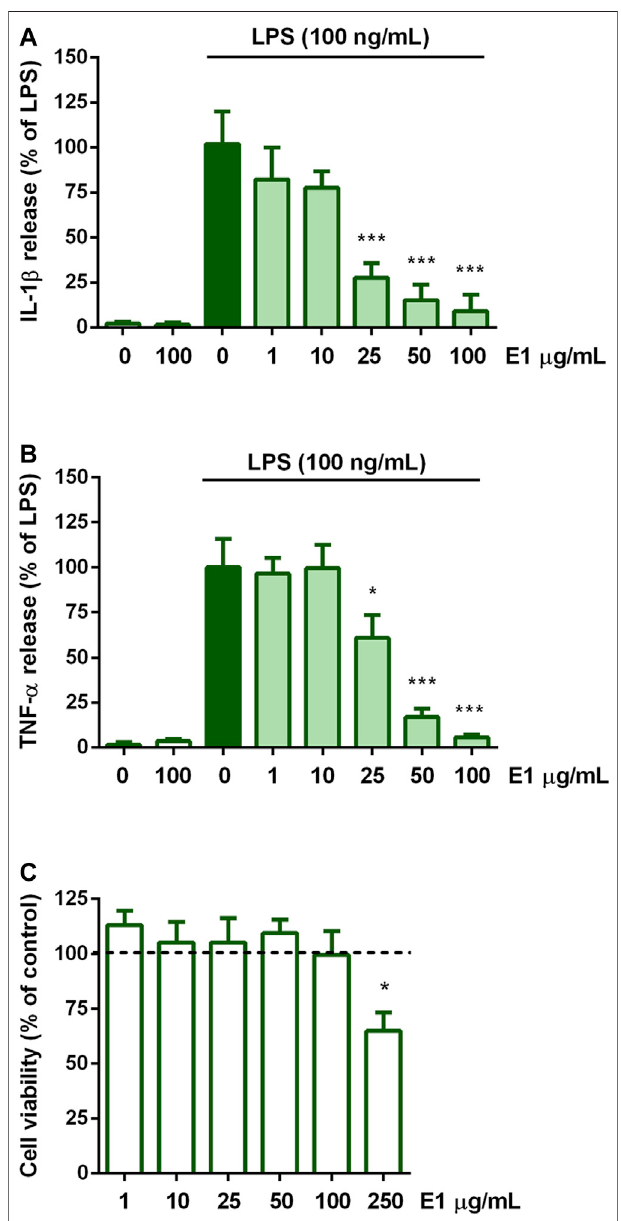
FIGURE 2 | Effect of pre-treatment with Spirulina extract on cytokine release from LPS-stimulated cortical microglia and cell viability analysis. Microgliawereculturedfor24 hin10%serum-containingmedium,whichwas replaced with serum-free medium before pre-treatment with E1 (1 – 100 μ g/ml) for 1 h and further stimulation with 100 ng/ml LPS for 16 h. Supernatantswerecollectedandanalyzedfor (A) IL-1 β and (B) TNF- α release. Results are expressed as percentage of cytokine release relative to LPS- stimulated microglia (dark green bars). Data are means ± SEM of three independent experiments. * p < 0.05 and *** p < 0.001 versus LPS stimulation. One-wayANOVAfollowedbySidak ’ smultiplecomparisontest. (C) Attheend of16 hincubation withE1(1 – 250 μ g/ml),cellviabilitywasdeterminedbySRB assay. Results are expressed as percentage of cell viability relative to control cells(dashedline).Dataarepresentedasmeans ± SEM( n (cid:1) 3intriplicate).* p < 0.05 versus control cells. One-way ANOVA followed by Sidak ’ s multiple comparison